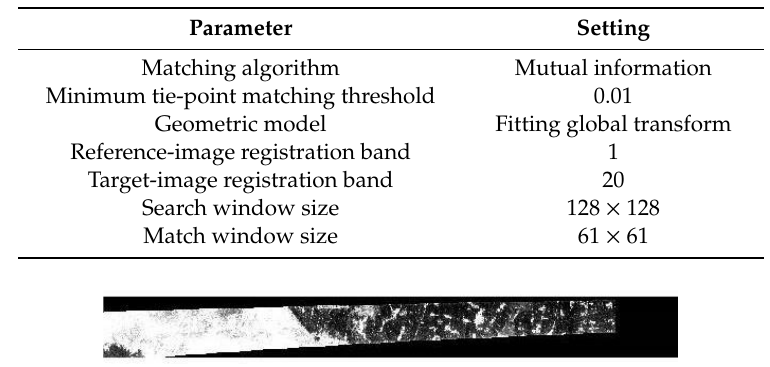
Table 1. Parameter settings for the ENVI Image Registration Workflow.